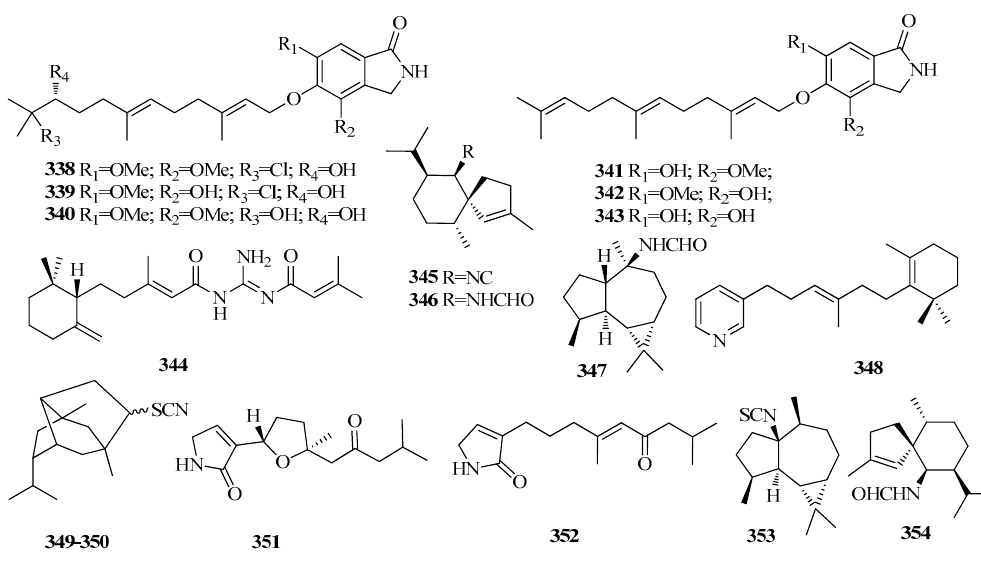
Figure 9. The structures of compounds 338 – 354.